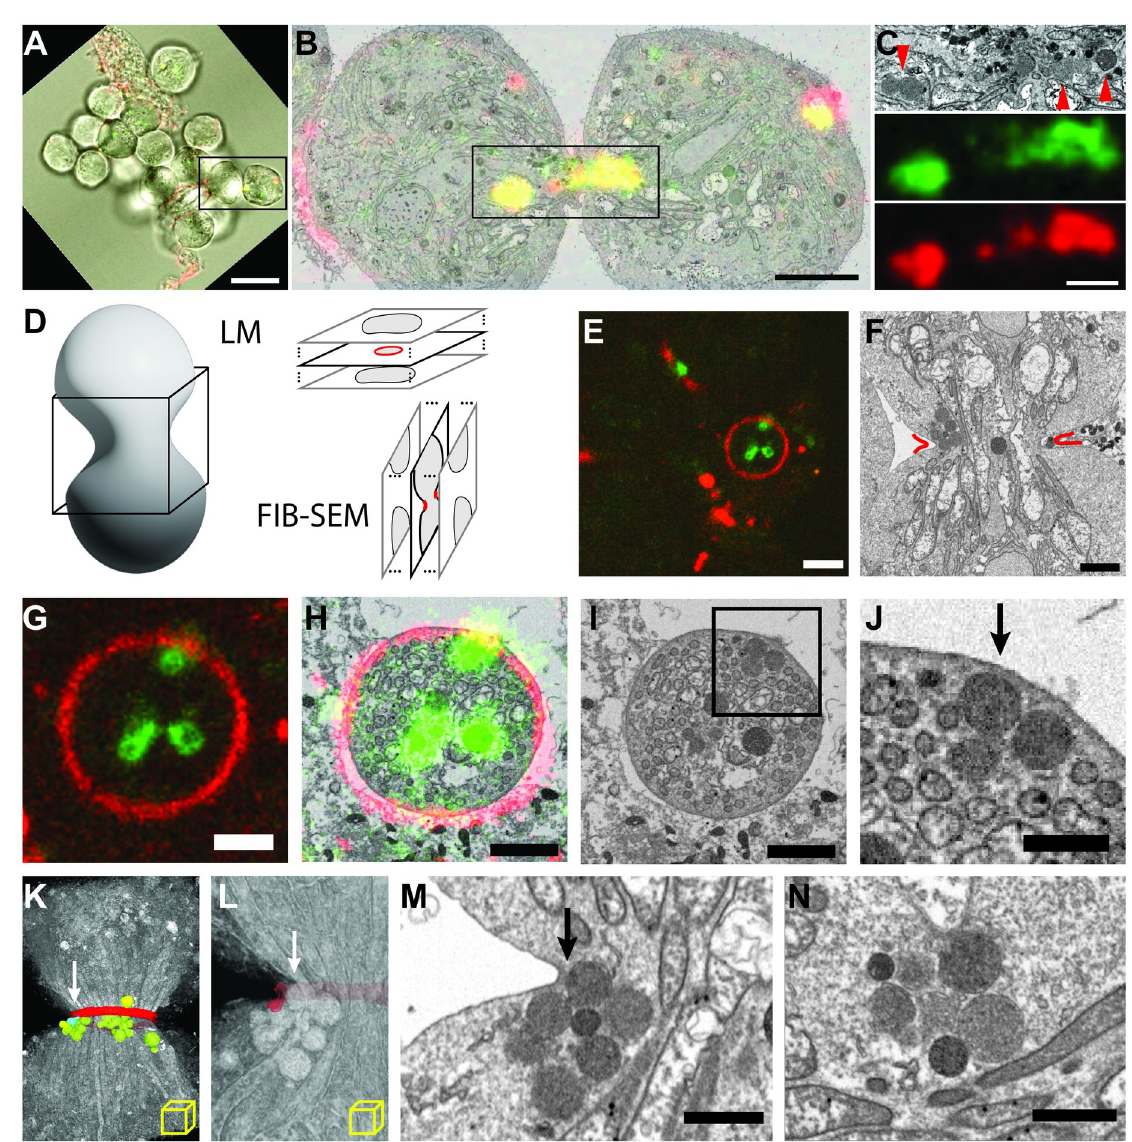
Fig 7. CPE positive endosomes dock at the ingressing cytokinetic furrow during meiosis. (A) Combined transmitted and fluorescence image of dissected Drosophila cyst; dividing cells chosen for FIB-SEM imaging are boxed. Green, eYFP-Rab7; red, PlyA2-mCherry. Scale bar: 20 μ m. (B) 2D section from FIB-SEM reconstruction correlated with “z slice” from confocal. Colors as in A, saturated for ease of visualization. Scale bar: 5 μ m. (C) Area boxed in B; FIB-SEM image (top), Rab7 (middle), PlyA2 (bottom). Arrowheads indicate electron- dense endosomes. Scale bar: 2 μ m. (D) Volumetric imaging of dividing spermatocytes, showing orthogonal imaging planes, and expected cross sections for LM and FIB-SEM. (E) Fluorescence “z slice” capturing a cleavage furrow in-plane. Scale bar: 4 μ m. (F) FIB-SEM image capturing same furrow as in E cross-section, approximated by red lines. Scale bar: 2 μ m. (G–I) Correlated fluorescence image, overlay, and rotated FIB-SEM section, respectively, of furrow in-plane. (J) Area boxed in I showing endosomes docked at the furrow (arrow). Scale bar: 1 μ m. (J and K) Volume rendering of FIB-SEM 3D reconstruction, with furrow segmented and false colored red, undocked endosomes green, docked endosomes blue. (L) Close-up of K, with furrow segmented translucent and endosomes unsegmented. (M) Matching FIB-SEM section in the imaging plane. Arrows in K, L, M show same endosomes docked at furrow. Scale bar: 2 μ m. (N) Independent CLEM/ FIB-SEM experiment revealing at higher pixel sampling another example of docked vesicle. Scale bar: 1 μ m. CPE, ceramide phosphoethanolamine; LM, light